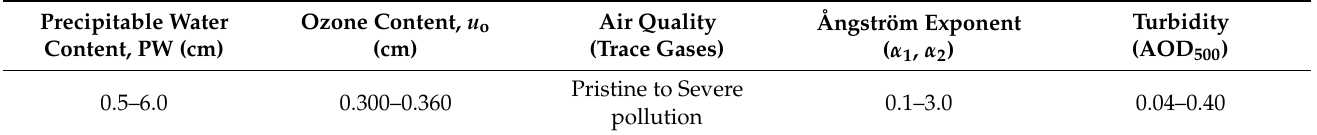
Table 1. Input values being varied in SMARTS and their range of tolerance for the fitting